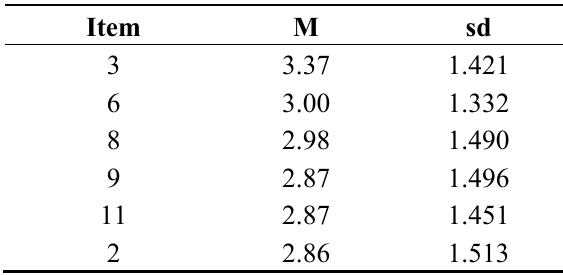
Table 1. Means (M) and standard deviations (sd) of individual items of the questionnaire are ordered by the size of the arithmetic